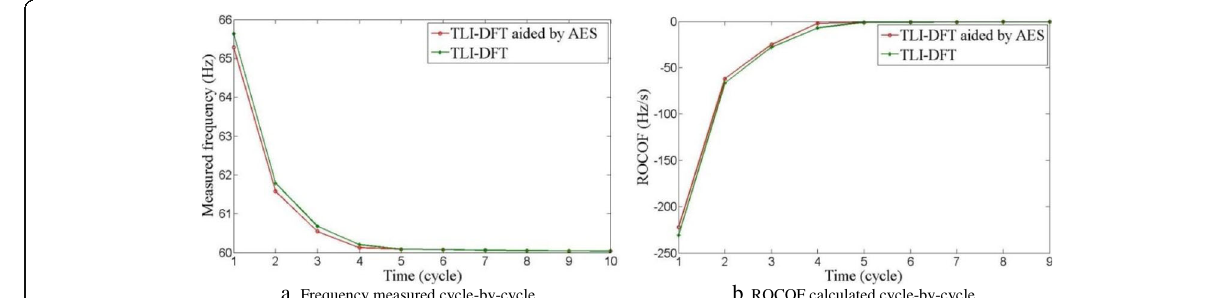
Fig. 17 Frequency tracking and ROCOF by TLI-DFT with decaying DC